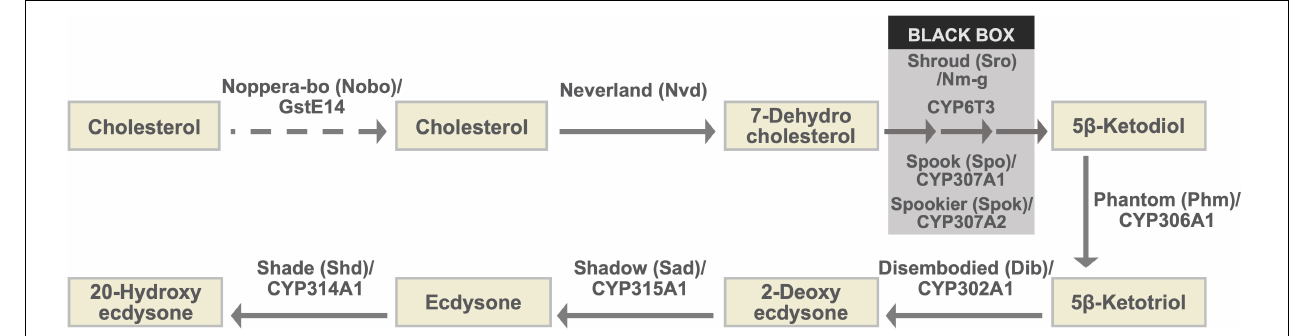
FIGURE 1 | The ecdysteroid biosynthesis pathway and Halloween enzymes. As the conversion steps between 7-dehydrocholesterol and 5 β -ketodiol have not been chemically characterized, they are collectively called the “Black Box.” Notably, spo and spok are paralogous to each other (Ono et al., 2006; Komura-Kawa et al., 2015). Although genetic and physiological analyses have suggested that Nobo plays a role in cholesterol intake or trafficking in the PG, endogenous substrates of Nobo have not been identified. Therefore, the role of Nobo is indicated by the dashed arrow in this